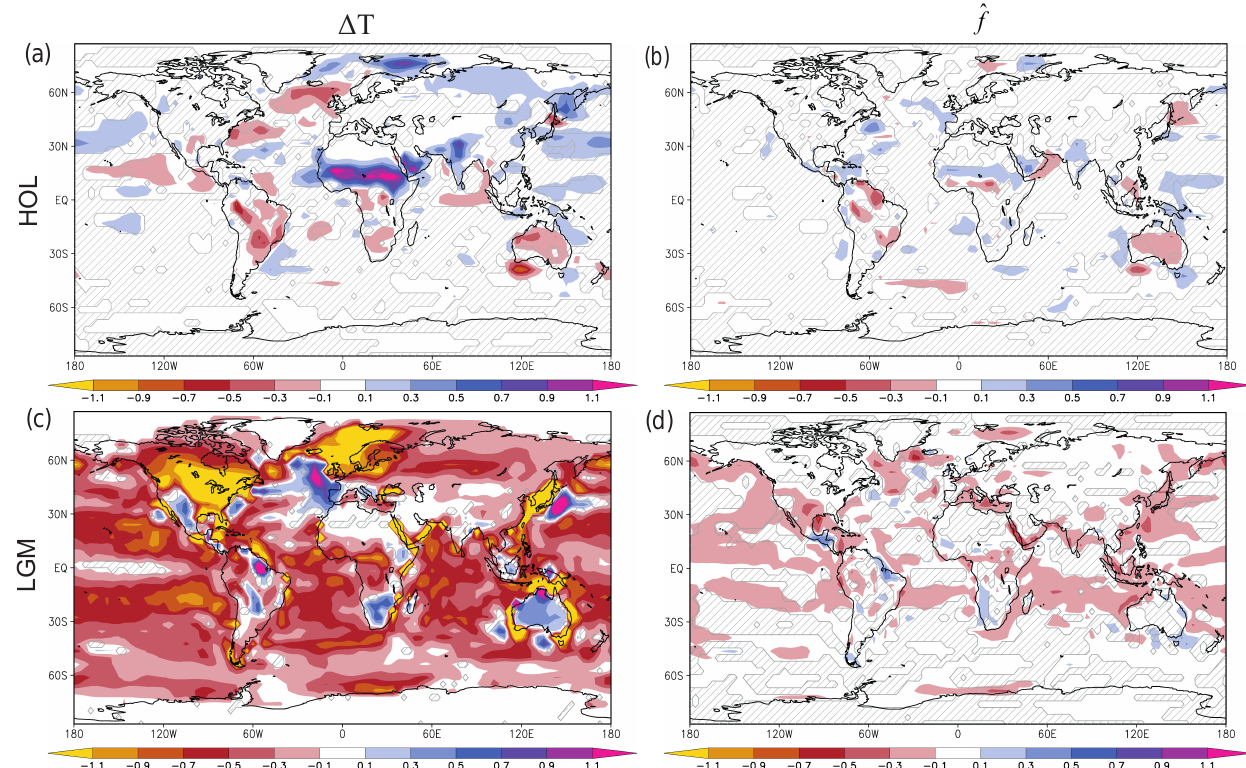
Figure 6. As Fig. 4 but for evaporation (kilograms per square metre per